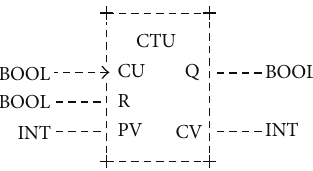
Figure1:Graphicalrepresentationoftheinterfaceoftheup-counter